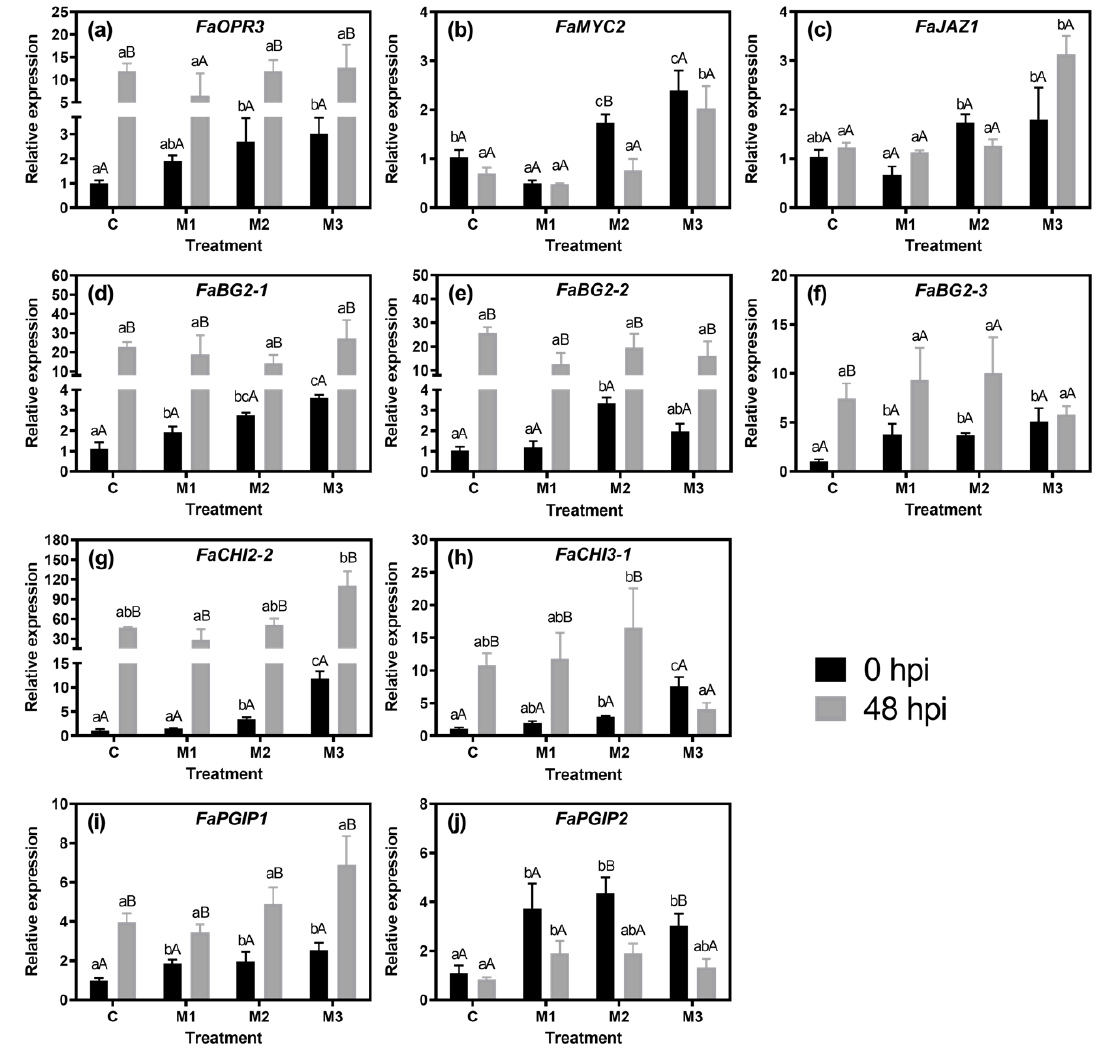
Figure 4 . Expression profiles of genes encoding for jasmonate pathway-related components, PR- (β-1,3-glucanases and chitinases), and PGIP-related genes: ( a ) FaOPR3 , ( b ) FaMYC2 , ( c ) FaJAZ1 , ( d ) FaBG2-1 , ( e ) FaBG2-2 , ( f ) FaBG2-3 , ( g ) FaCHI2-2 , ( h ) FaCHI3-1 , ( i ) FaPGIP1 , and ( j ) FaPGIP2 in